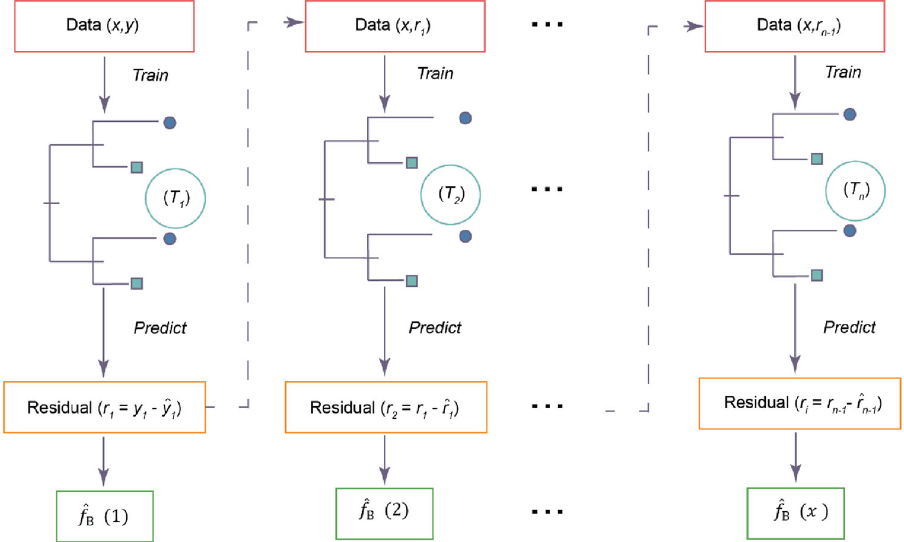
^ f B ð x Þ , by fi tting the boosted